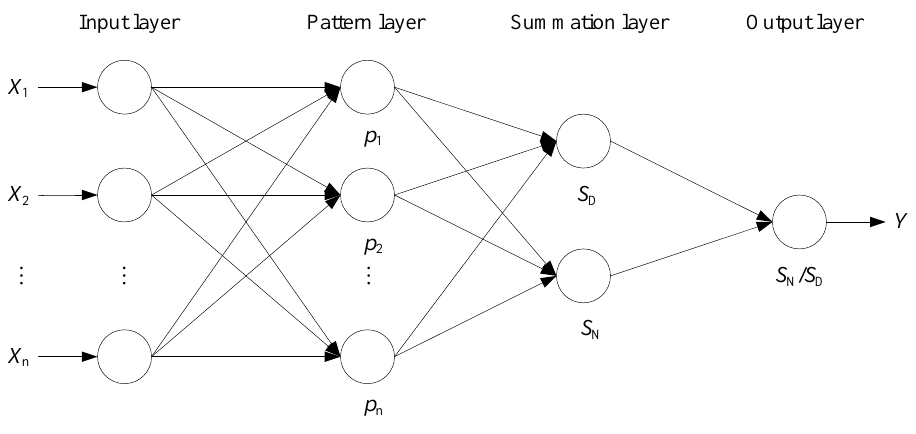
Figure 1. Structure of generalized regression neural network